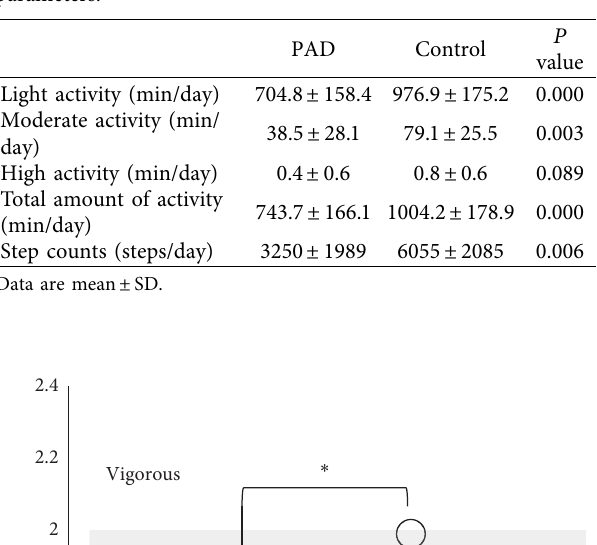
Table 2: Average durations of different intensity levels and walking parameters.